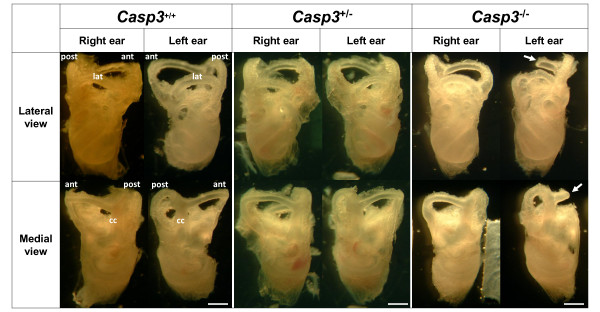
Vestibular dysmorphism in caspase-3 deficient mice. Temporal bones of Casp3-/-, Casp3+/- and Casp3+/+ mice at postnatal day 20. Truncation of the left superior semicircular canal in a Casp3-/- mouse is shown (arrow). Most Casp3-/- (n = 14) had variable degrees of dysmorphisms in the anterior semicircular canal, whereas all Casp3+/- (n = 20) and Casp3+/+ (n = 14) had normal inner ear morphology. ant, anterior semicircular canal. lat, lateral semicircular canal. post, posterior semicircular canal. cc, common crus. Scale bar, 1mm.